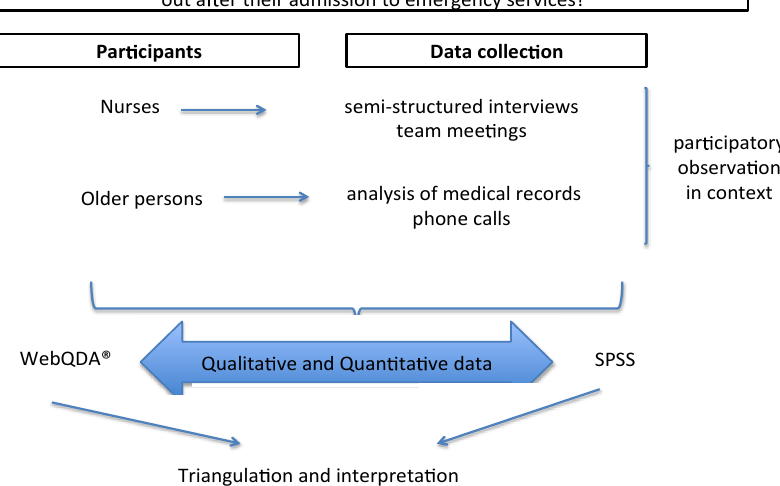
Figure 1. Study design. Vila Franca de Xira; Portugal.